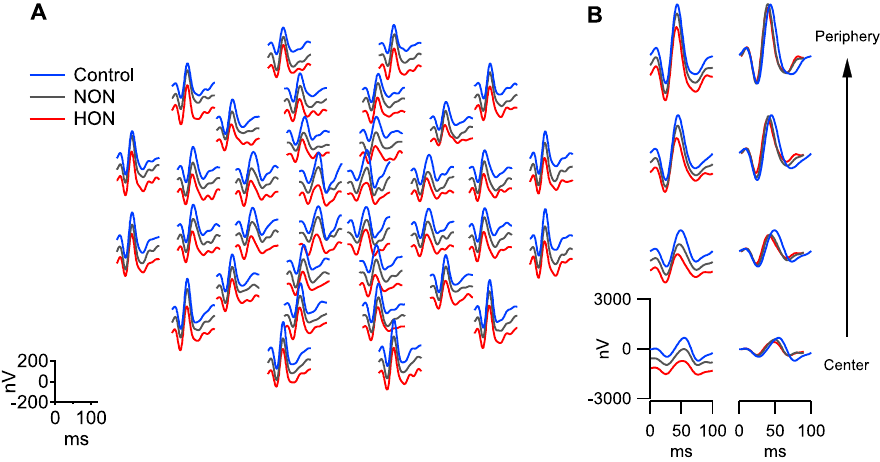
Figure 1. Grand mean traces of each group. ( A ) The grand mean of each of the 36 elements of the mfPERG stimulus. ( B ) The summed trace for the 4 rings of the mfPERG stimulus from the center to the periphery, i.e., central ring (ring 1): 4 elements; ring 2: 8 elements; ring 3: 12 elements; ring 4: 12 elements. Traces are offset between groups for A and left panel in B for